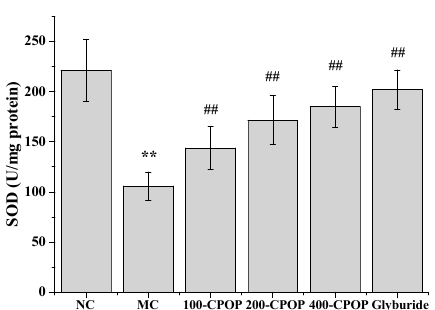
Figure 9. Effects of CPOP on superoxygen dehydrogenises (SOD) activities in liver tissues of STZ-induced diabetic rats. ** p < 0.01 vs. NC group ( N = 8); ## p < 0.01 vs. MC group ( N = 8). NC is the normal control group; MC is the model control group; 100-CPOP is the 100 mg/kg per body weight CPOP group; 200-CPOP is the 200 mg/kg per body weight CPOP group; 400-CPOP is the 400 mg/kg per body weight CPOP group.